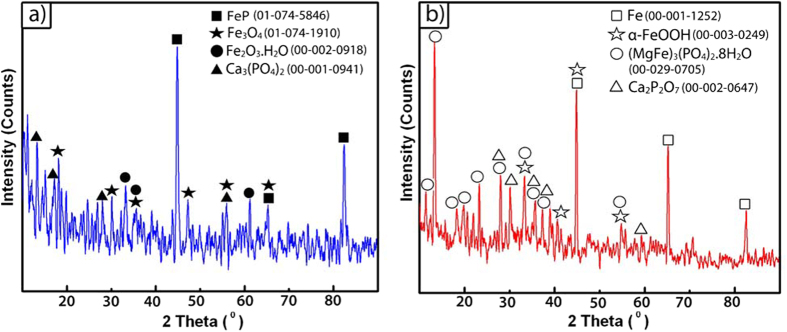
XRD patterns of the degraded:(a) PPI and (b) PIPI samples. Note: PDF numbers are given in the bracket.